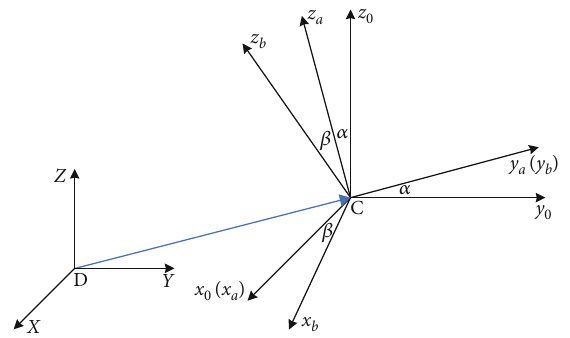
Figure 2: Coordinate system of dual-axis data transmission